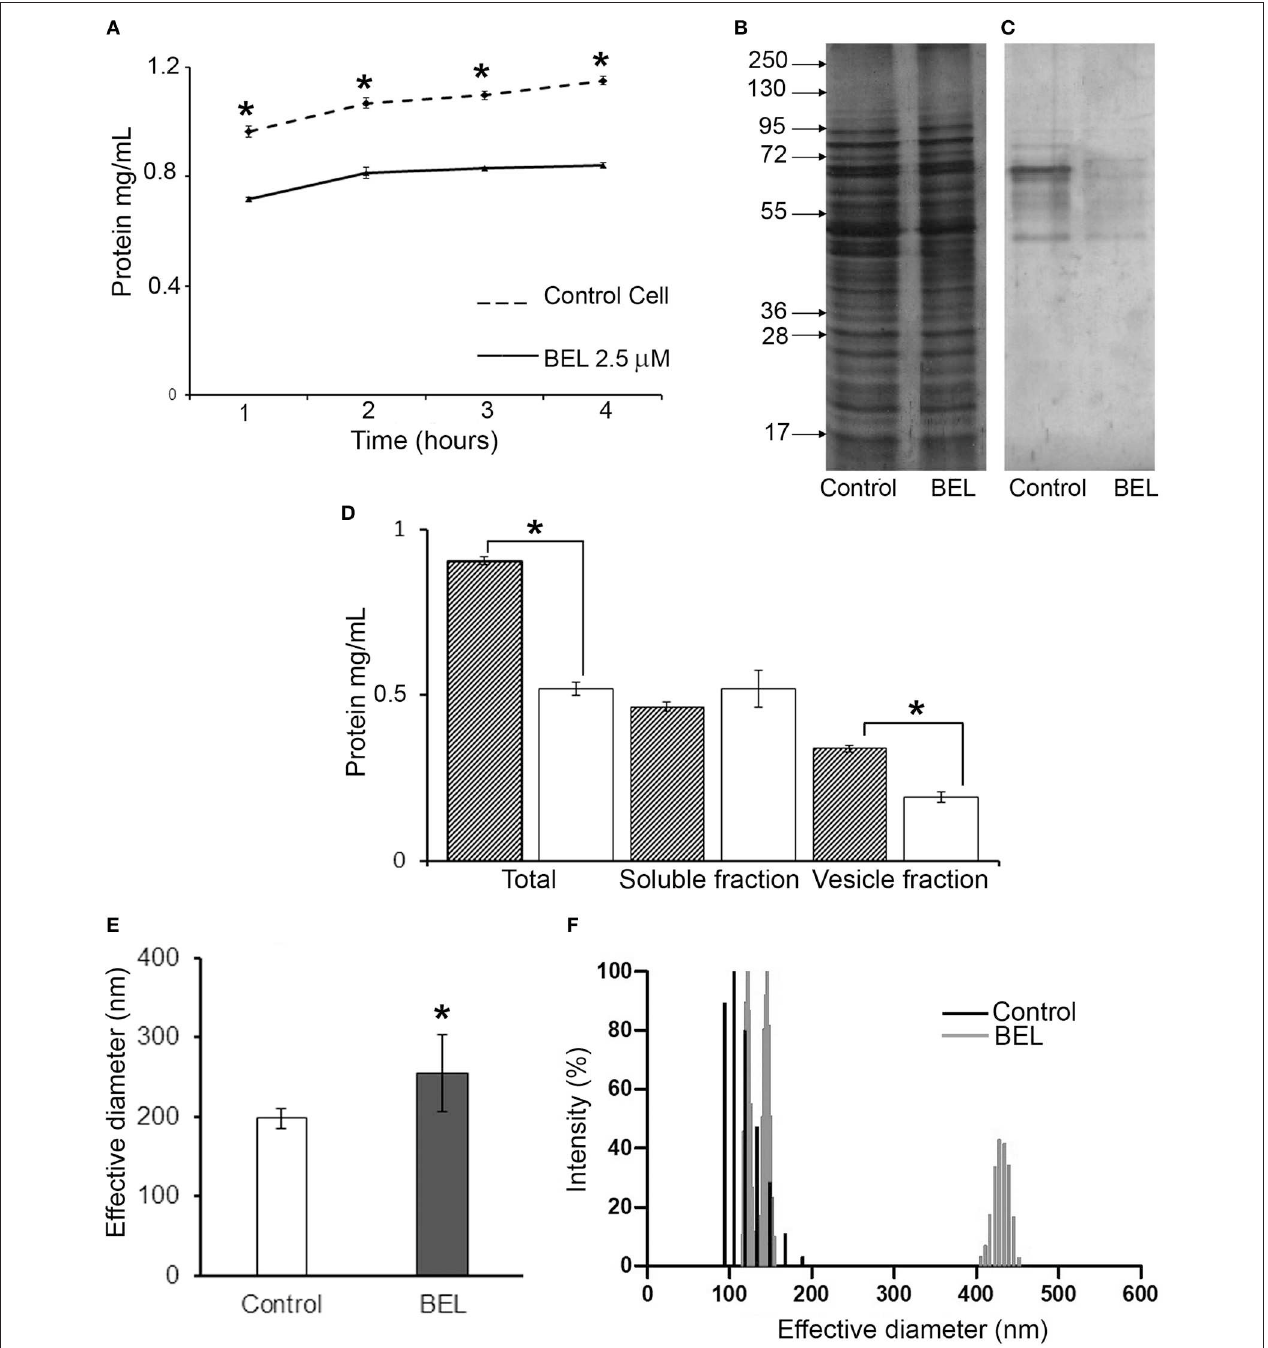
FIGURE 3 | Effect of bromoenol lactone (BEL) on the protein secretion by Leishmania amazonensis promastigotes. (A) Kinetics of protein secretion by promastigotes untreated (control) or treated with 2.5 µ M of BEL for 1h, and then incubated at 26 ◦ C for 4h in Hank’s balanced salt solution (HBSS). Protein concentrations in the conditioned medium were estimated using Bradford. Data represent mean ± SEM values from three independent experiments, performed in duplicates. * p < 0.05. (B,C) SDS-PAGE profile of intact cells (B) and of conditioned media (C) from untreated control and BEL-treated parasites (all lanes contain samples derived from equivalent numbers of cells). Molecular weight markers are indicated on the left. (D) Total amount of protein in the conditioned media (Total), soluble fractions and vesicle fraction of control (gray bars) and BEL-treated parasites (white bars). (E,F) Effective diameter and the polydispersity of L. amazonensis vesicles obtained from control and BEL-treated promastigotes were analyzed by dynamic light scattering (DLS). Results shown as effective diameter in nm and % of intensity of 5 different measurements * p < 0.05.